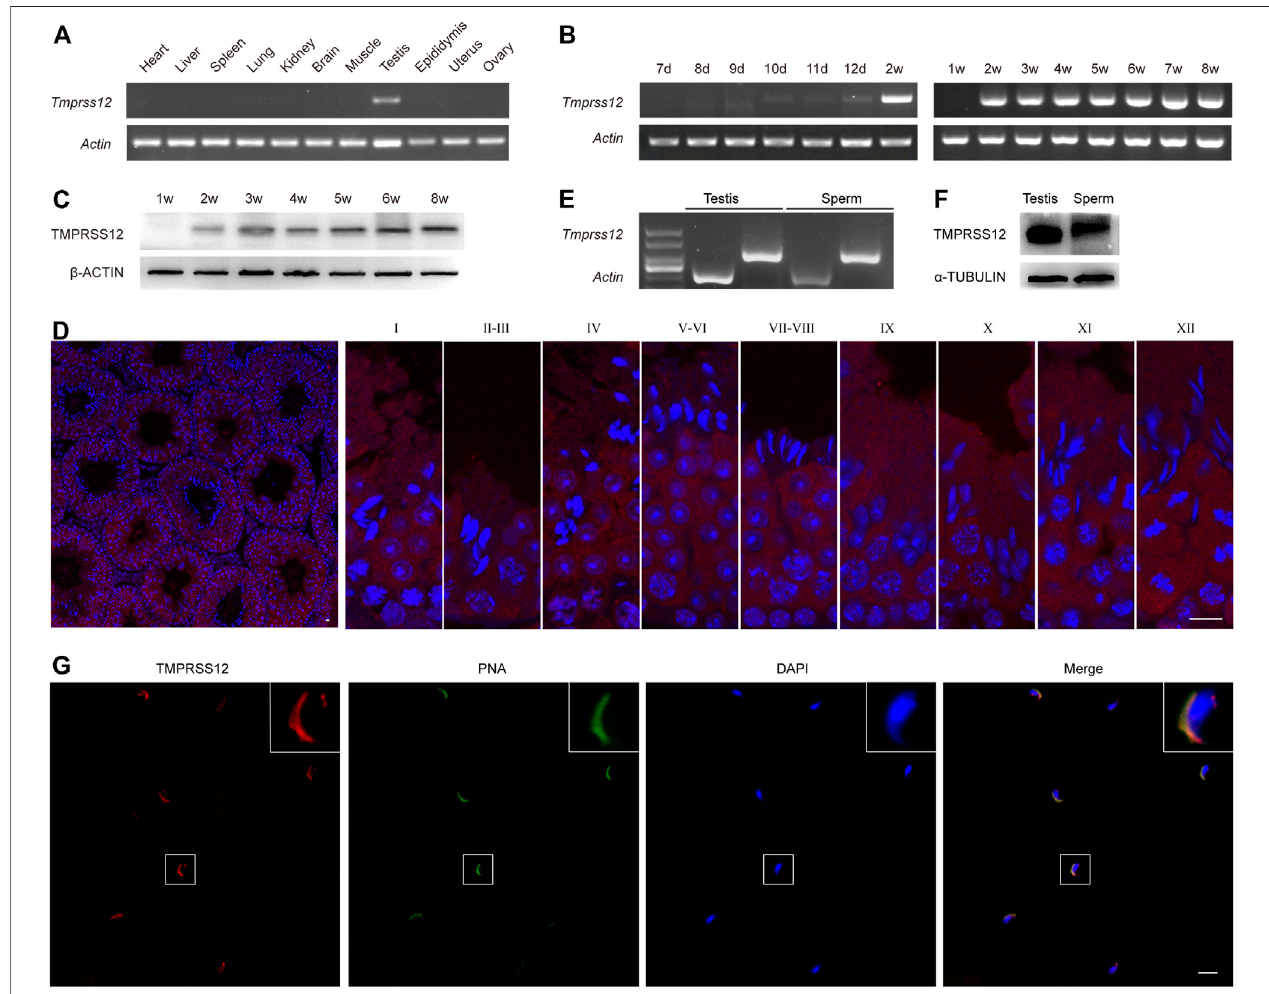
FIGURE1| TMPRSS12isexpressedintesticularspermatocytesandspermatidsaswellassperm. (A) Expressionof Tmprss12 mRNAinvarioustissuesfromadult micewasdetected byRT-PCR. TMPRSS12wasspeci fi cally expressed in thetestis. Actin wasused asaninternal control. (B) Expressionoftesticular Tmprss12 mRNA attheindicatedtimepointsafterbirthwasexaminedbyRT-PCR,showingthatitsexpression fi rstappearedin10-day-oldmice. Actin wasusedasaninternalcontrol. (C) Western blot of TMPRSS12 from the testes of mice at different weeks of age. TMPRSS12 was observed in 2-week-old mice and continued until adulthood. β - ACTIN was used as an internal control. (D) Immuno fl uorescence staining of testis sections from adult mice for TMPRSS12 (red), with nuclei counterstained by DAPI (blue).Eachimageexhibitsastageoftheseminiferousepithelialcycle,andtheyaredenotedbyRomannumeralsatthetopofeachimage.TheexpressionofTMPRSS12 initiated from spermatocytes and remained until step 12 elongated spermatids. Scale bar: 10 µm. (E) Expression of Tmprss12 was examined by RT-PCR using RNA isolated from mouse sperm. Actin was used as an internal control. (F) Western blot of TMPRSS12 in mouse sperm. α -TUBULIN was used as an internal control. (G) Immuno fl uorescence staining of mouse sperm for TMPRSS12 (red). The nuclei and acrosomes of sperm were labelled with DAPI (blue) and PNA (green), respectively. The images in the upper right corner are enlarged views of the sperm. Scale bar: 20 µm.